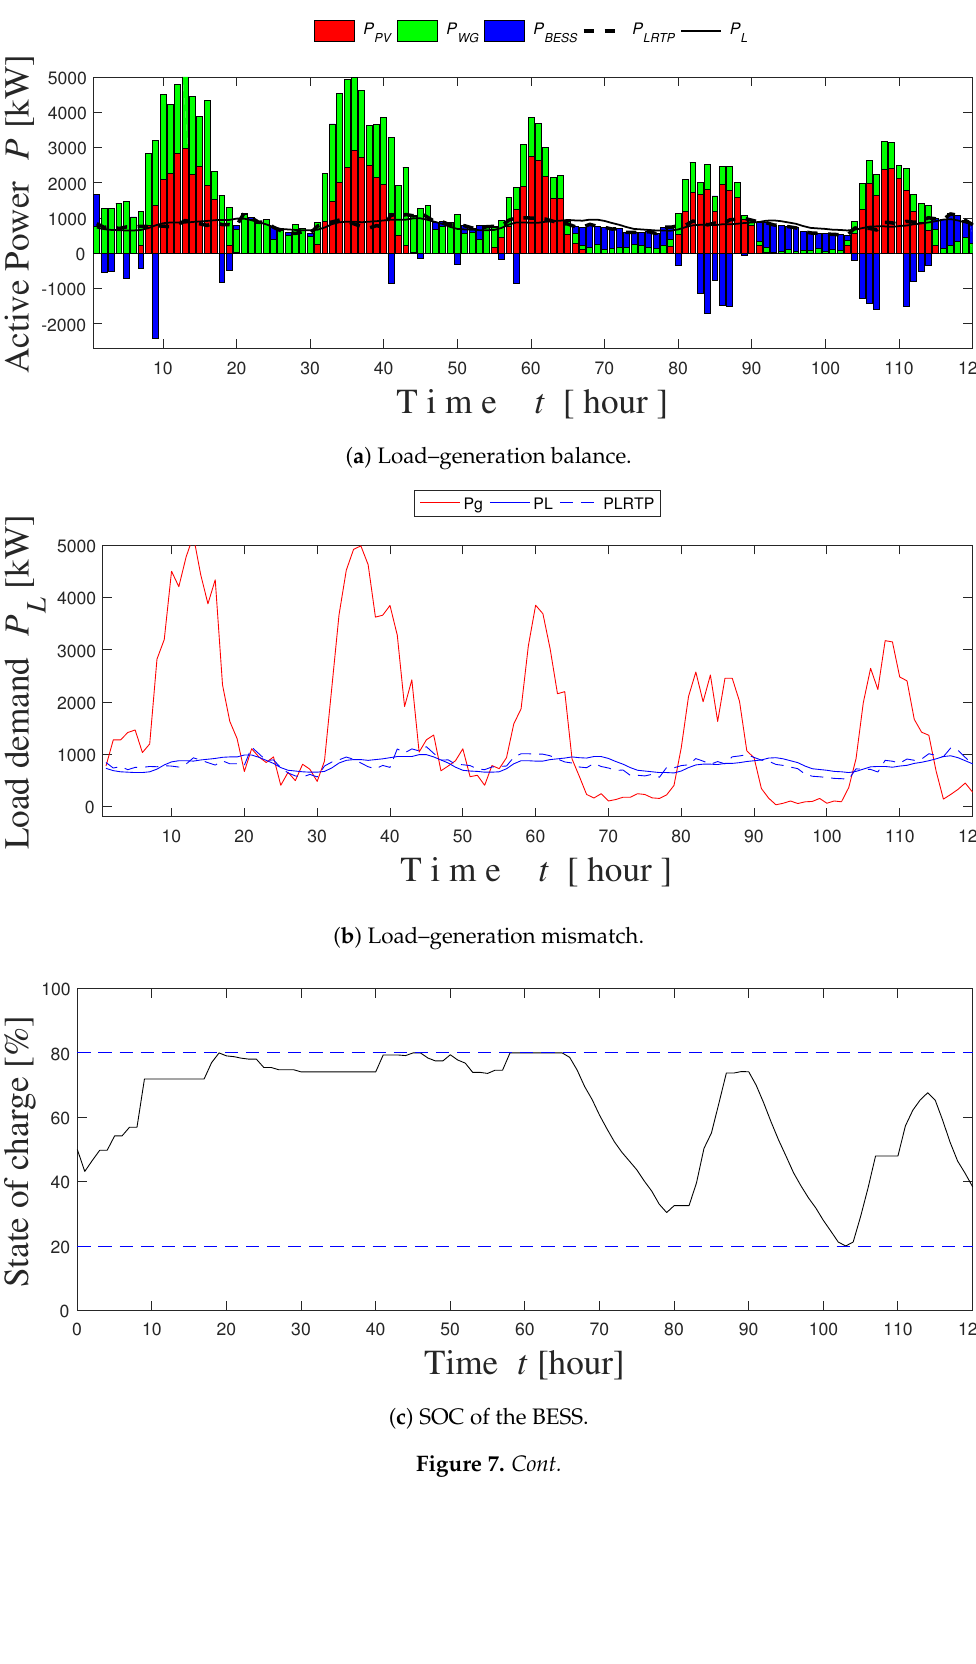
( c ) SOC of the BESS. Figure 7.